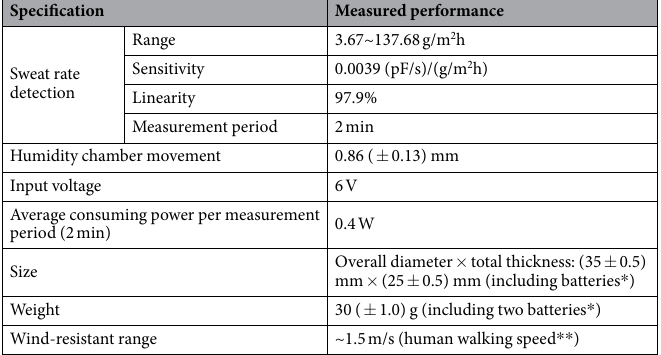
Table 1. Specification of the watch-type sweat rate sensors. * CR2032, lithium coin, 3 V, 240mAh. ** A. Pepin, et al . Spinal Cord